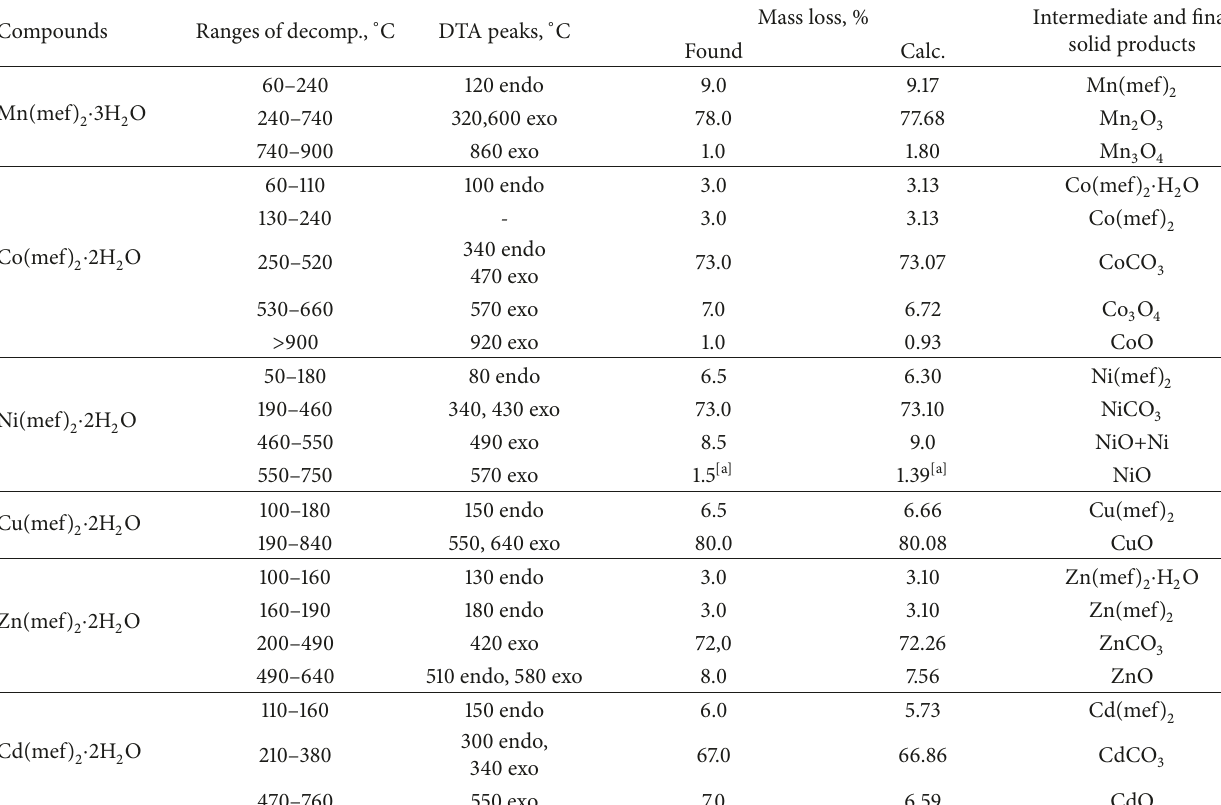
Table 3: Thermal decomposition data of complexes in air.